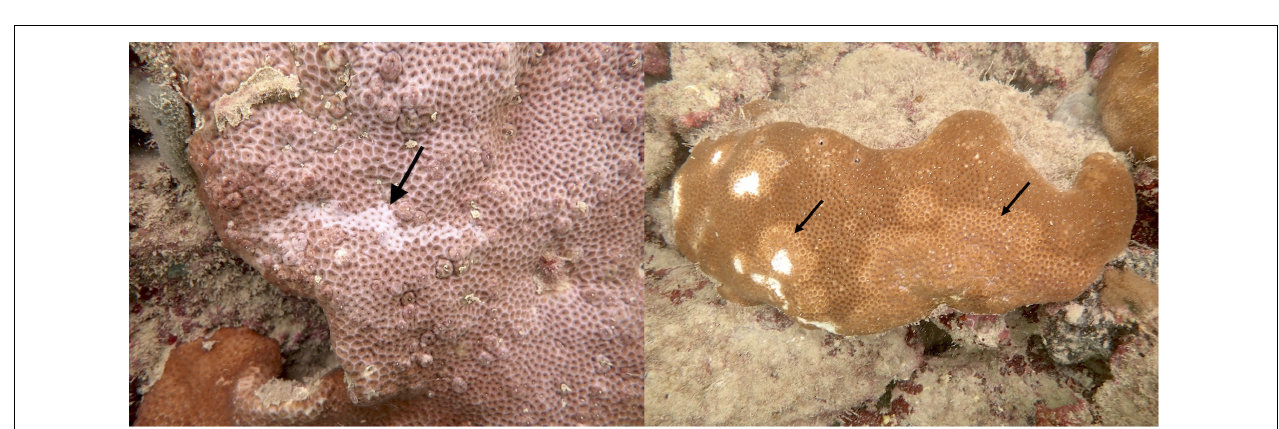
FIGURE 3 | Examples of bleached lesions on S. siderea from Fort Lauderdale not indicative of SCTLD.